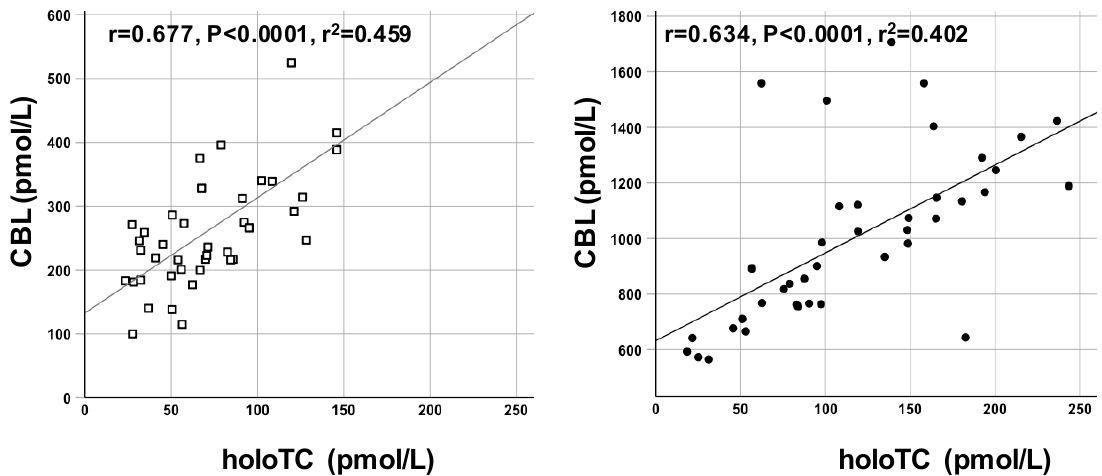
Figure 1. Positive correlations between CBL and holoTC concentrations in semen ( A ) and serum ( B ) in all subjects. Correlations were evaluated by Spearman’s test for not-normally distributed data in a univariate analysis: r, r 2 , and p from linear regression are indicated. CBL: cobalamin; holoTC: holotranscobalamin